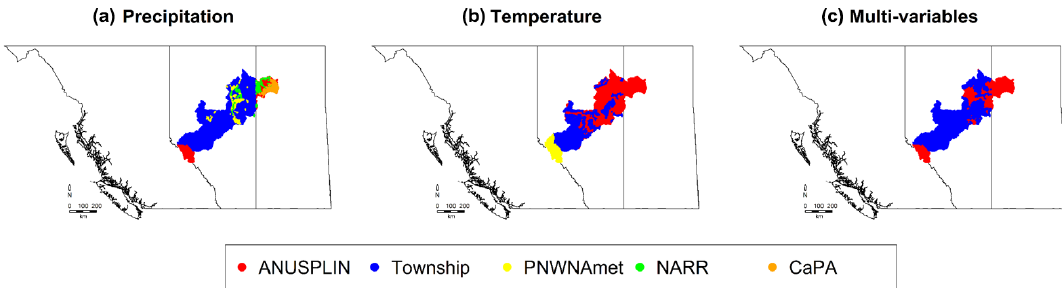
Figure 9. Maps of the first-ranked climate datasets in the ARB for the individual variable (a, b) and multi-variables (c)